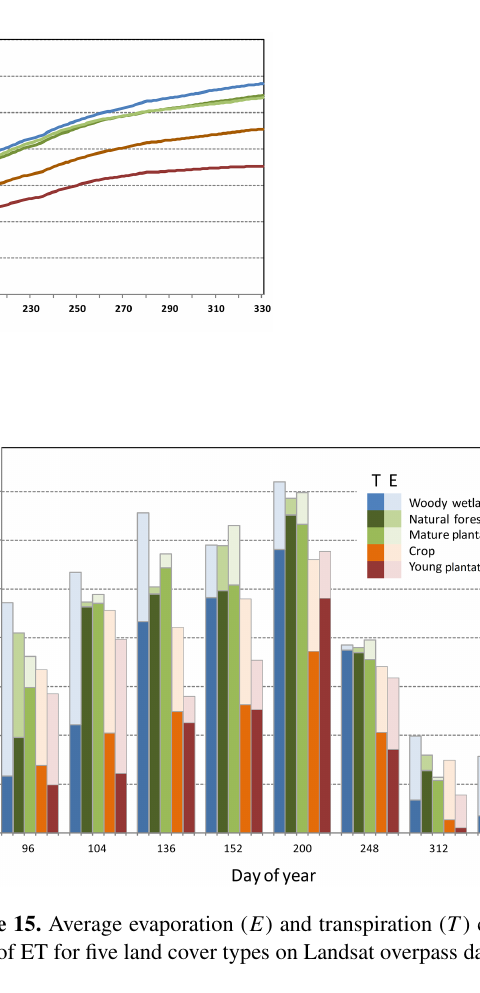
Figure 12. Time series of modeled plot-scale ET (daily values smoothed with a 7-day moving average) associated with different land cover types.